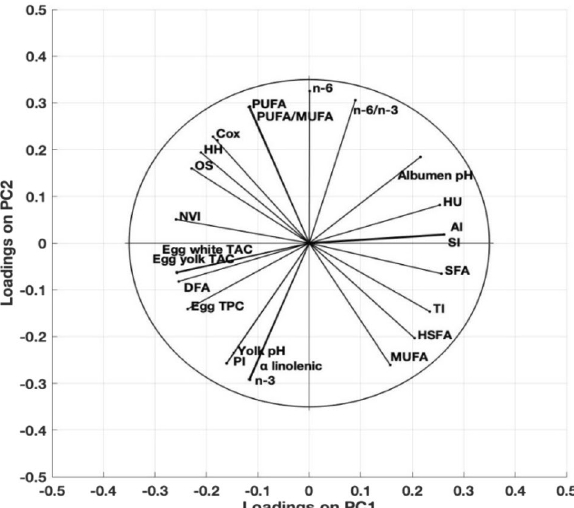
Figure 1. Principal component analysis and correlation loading of fatty acids, health indices, total phenolic compounds, antioxidant capacity, HU, yolk and albumen pH of the analysed egg